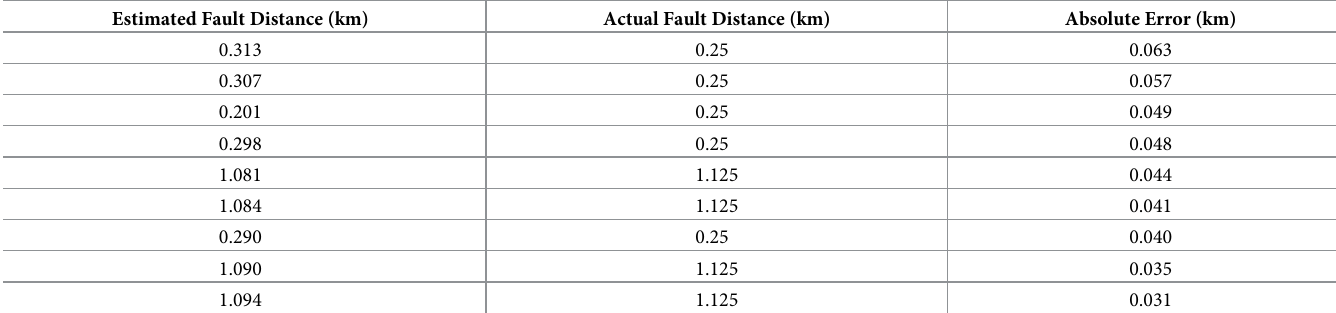
Table 4. Fault distance estimation using PSO-optimized ANN (18-bus).